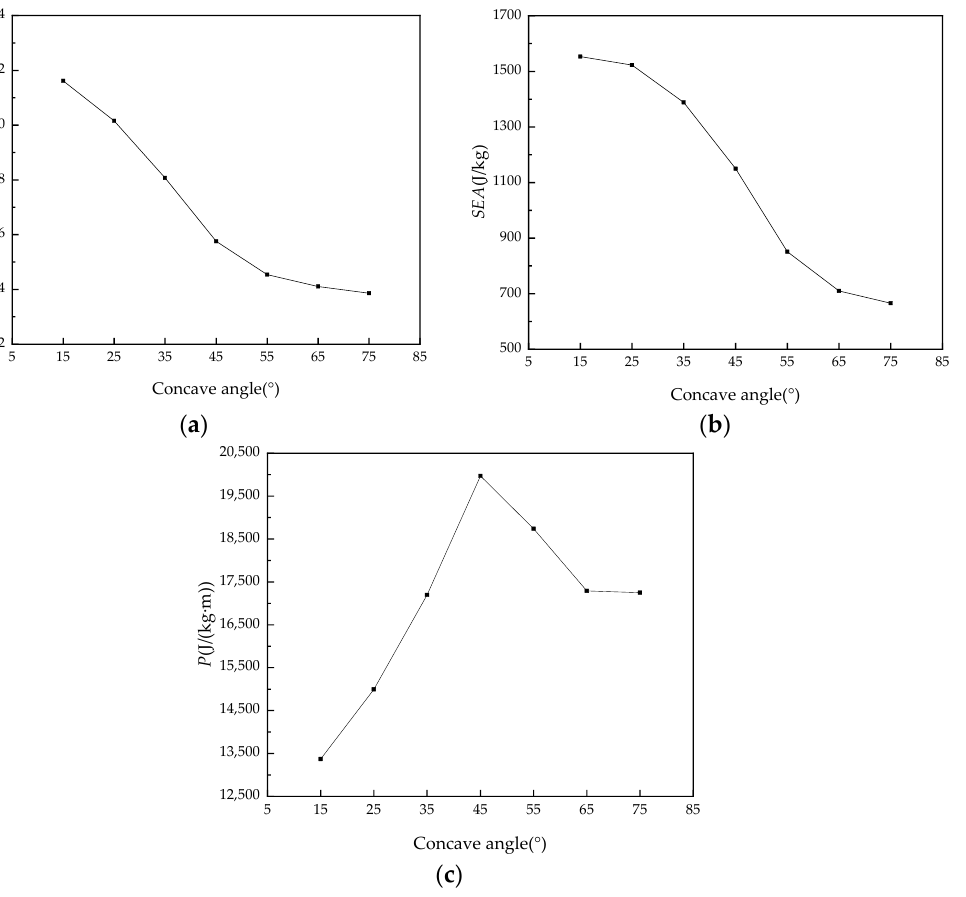
Figure 16. The curves of anti-blast indices of different concave angle. ( a ) δ max - θ curve; ( b ) SEA- θ curve; and ( c ) P- θ curve